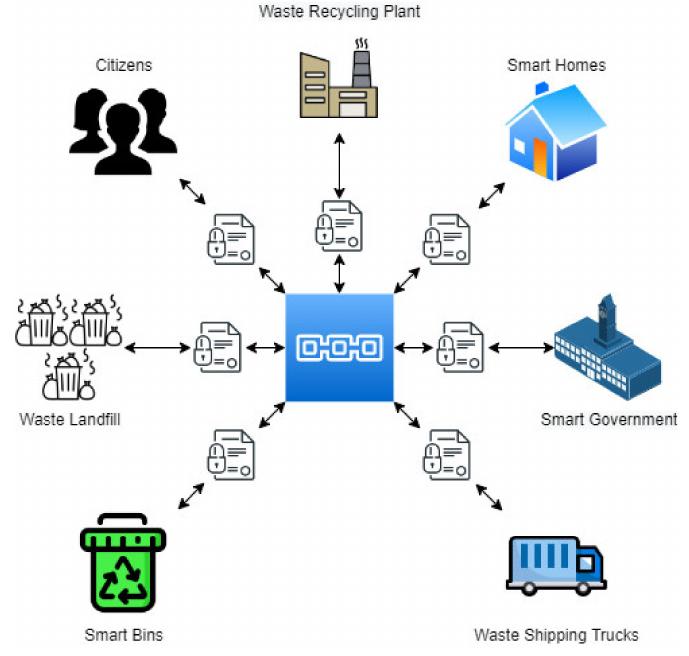
Figure 9. The waste management using blockchain.